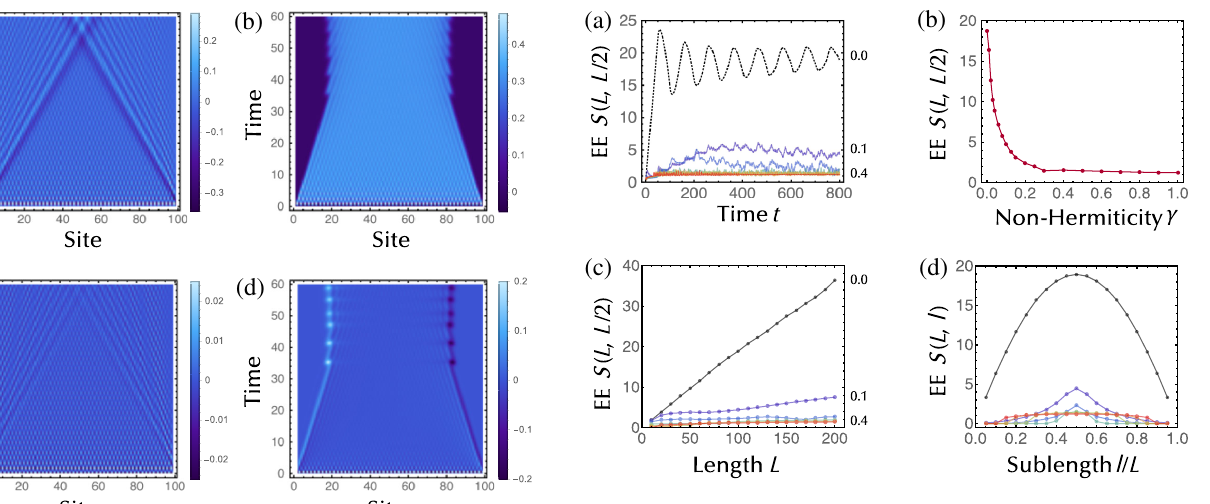
FIG. 6. Entanglement entropy (EE) of the Hatano-Nelson model with open boundaries ( J ¼ 1 . 0 ). The initial state is FIG. 5. Local current distribution in the Hatano-Nelson model prepared as the charge density wave state in Eq. (4). (a) Time with open boundaries ( J ¼ 1 . 0 ). The initial state is prepared as evolution of the entanglement entropy S ð L; L= 2 Þ ( L ¼ 100 ) for the charge density wave state in Eq. (4). (a),(b) Time evolution γ ¼ 0 . 0 (black dashed curve), 0.1 (violet curve), 0.2 (blue curve), ˆ I ψ ð t Þi for (a) γ ¼ 0 . 0 and of the local current I l ð t Þ ≔ h ψ ð t Þj l j 0.4 (green curve), 0.6 (light green curve), 0.8 (orange curve), and (b) γ ¼ 0 . 8 . (c),(d) Time evolution of the local particle inflow for 1.0 (red curve). (b) Entanglement entropy S ð L; L= 2 Þ for the (c) γ ¼ 0 . 0 and (d) γ ¼ 0 . 8 . steady state as a function of non-Hermiticity γ ( L ¼ 100 ). (c) Entanglement entropy S ð L; L= 2 Þ for the steady state as a function of the system length L . (d) Entanglement entropy S ð L; l Þ ( L ¼ 100 ) for the steady state as a function of the subsystem length l